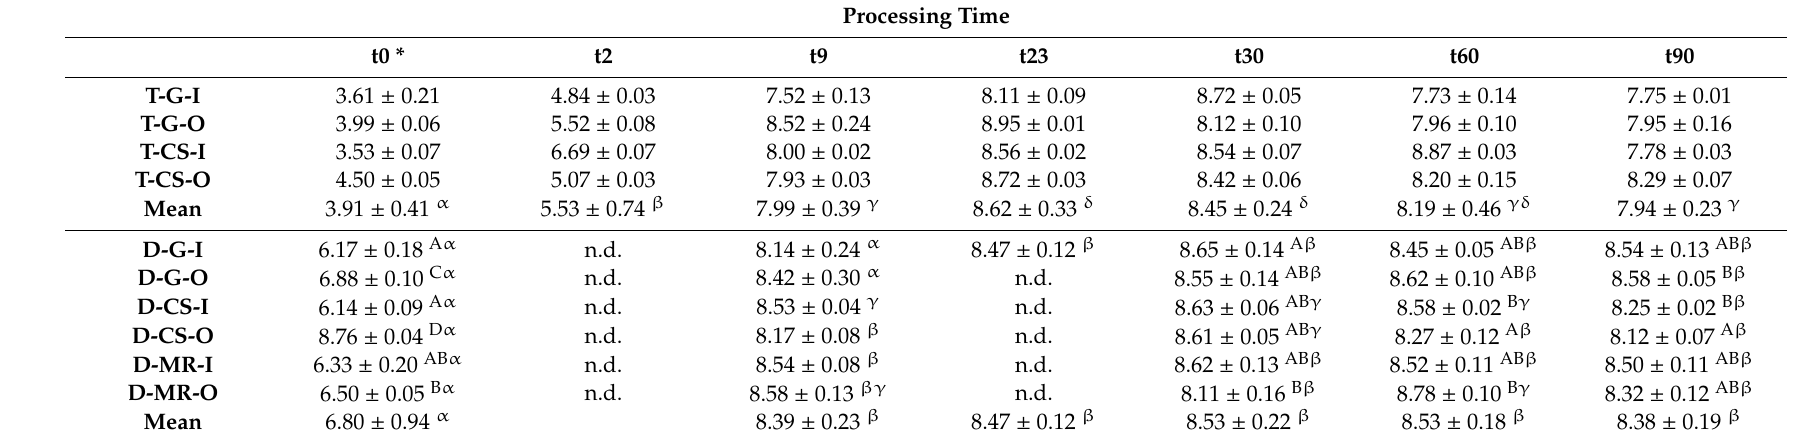
Table 1. Mean ± standard deviation of Lactic acid bacteria (LAB) colony counts, expressed as Log CFU / g, of sausages at di ff erent ripening days (t) and produced in two plants, industrial (D) and traditional (T) whose meats derived from pigs of three breeds, Goland (G), Cinta Senese (CS), and Mora Romagnola (MR) that were indoor (I) or outdoor (O)